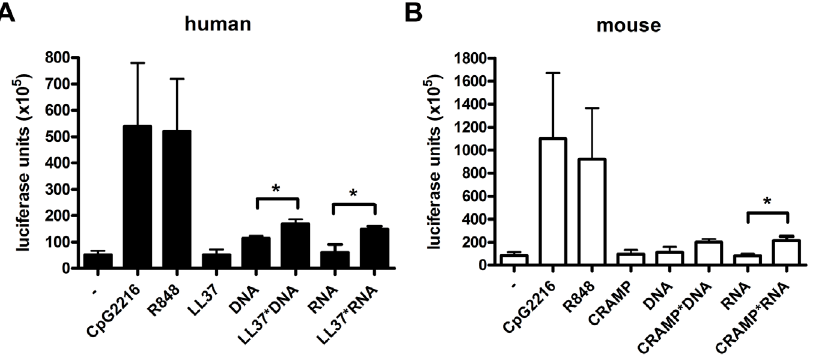
Fig. 9. Complexes of cathelicidins and RNA or DNA induce low production of IFN a . Bars show means and SEM of IFN a concentrations in supernatants from isolated human (A) or mouse (B) pDCs after incubation with free genomic DNA, free self-RNA, or DNA/RNA complexed to LL-37 (A) or (CRAMP). IFN a production from unstimulated pDCs or pDCs incubated with LL-37/CRAMP only was determined as a negative control, CpG2216 and R848 (Resiquimod) were used as a positive control for stimulation of TLR9 and TLR7/8, respectively. *p , 0.05, as determined by Student’s t-test. N 5